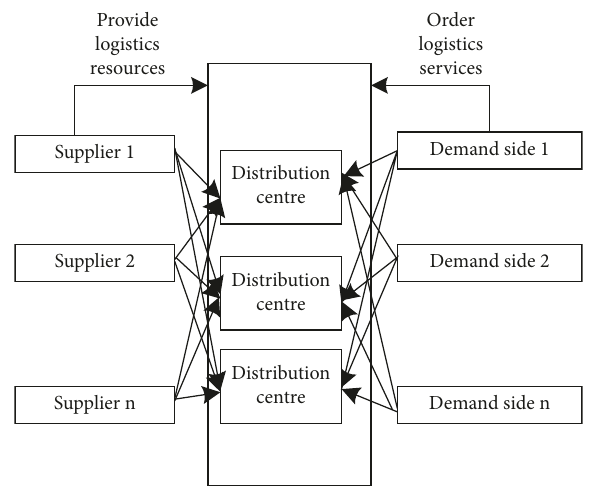
Figure 3: Distribution network under the cloud service